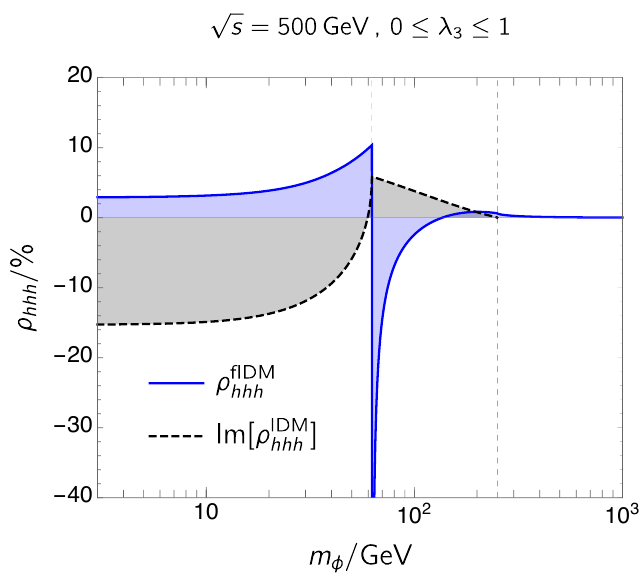
Figure 7 . ρ hhh as a function of the fake doublet mass m φ in the degenerate limit. The blue areas indicate the values of ρ hhh obtained for real contributions of the loop function in both the fIDM and IDM. Differently, the gray area shows the result of the imaginary part corresponding to the thresholds indicated in figure 6. This contribution vanishes within the fIDM but is generally present √ in the standard IDM. Notice the threshold m φ = s/ 2 , above which the two models give the same